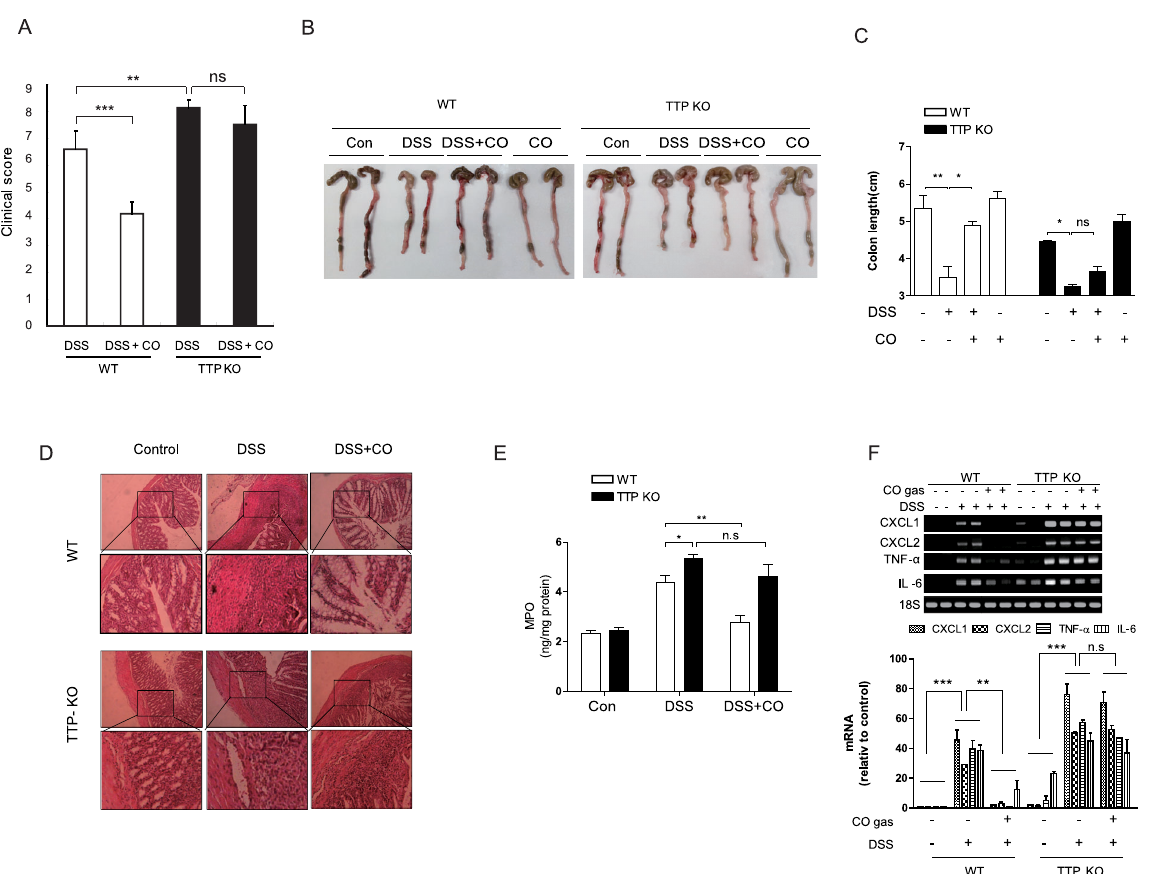
Figure 3. TTP deficiency blocks the anti-inflammatory function of CO in DSS-induced colitis. After treatment with 2% (w/v) DSS for 7 days, WT and TTP KO mice were exposed to CO at a concentration of 250 ppm for 5 days and analyzed for colitis. A. Clinical scores were assessed as described in Materials and Methods. Data are mean 6 SD for 5 mice (**, p , 0.01; ***, p , 0.005). ns, not significant. B and C. Colon length. B. Representative images of 5 tests conducted in each group. C. Data are mean 6 SD for 5 mice (*, p , 0.05; **, p , 0.01). D. Representative H&E sections of each group from colons of WT and TTP KO mice. E. Neutrophil infiltration into the colon, quantified by measuring MPO activity. Data are mean 6 SD for 5 mice (*, p , 0.05; **, p , 0.01). F. Colonic cytokine/chemokine mRNA levels, analyzed by semi-quantitative RT-PCR. Data represent 1 of 3 independent experiments with similar results. The band densities in the agarose gel were quantified by PhosphorImager, normalized to the internal control GAPDH and expressed as percentage (%) of the value of untreated control cells. Data shown are mean 6 SD (n=3). **, p , 0.01; ***, p , 0.005. ns, not significant.